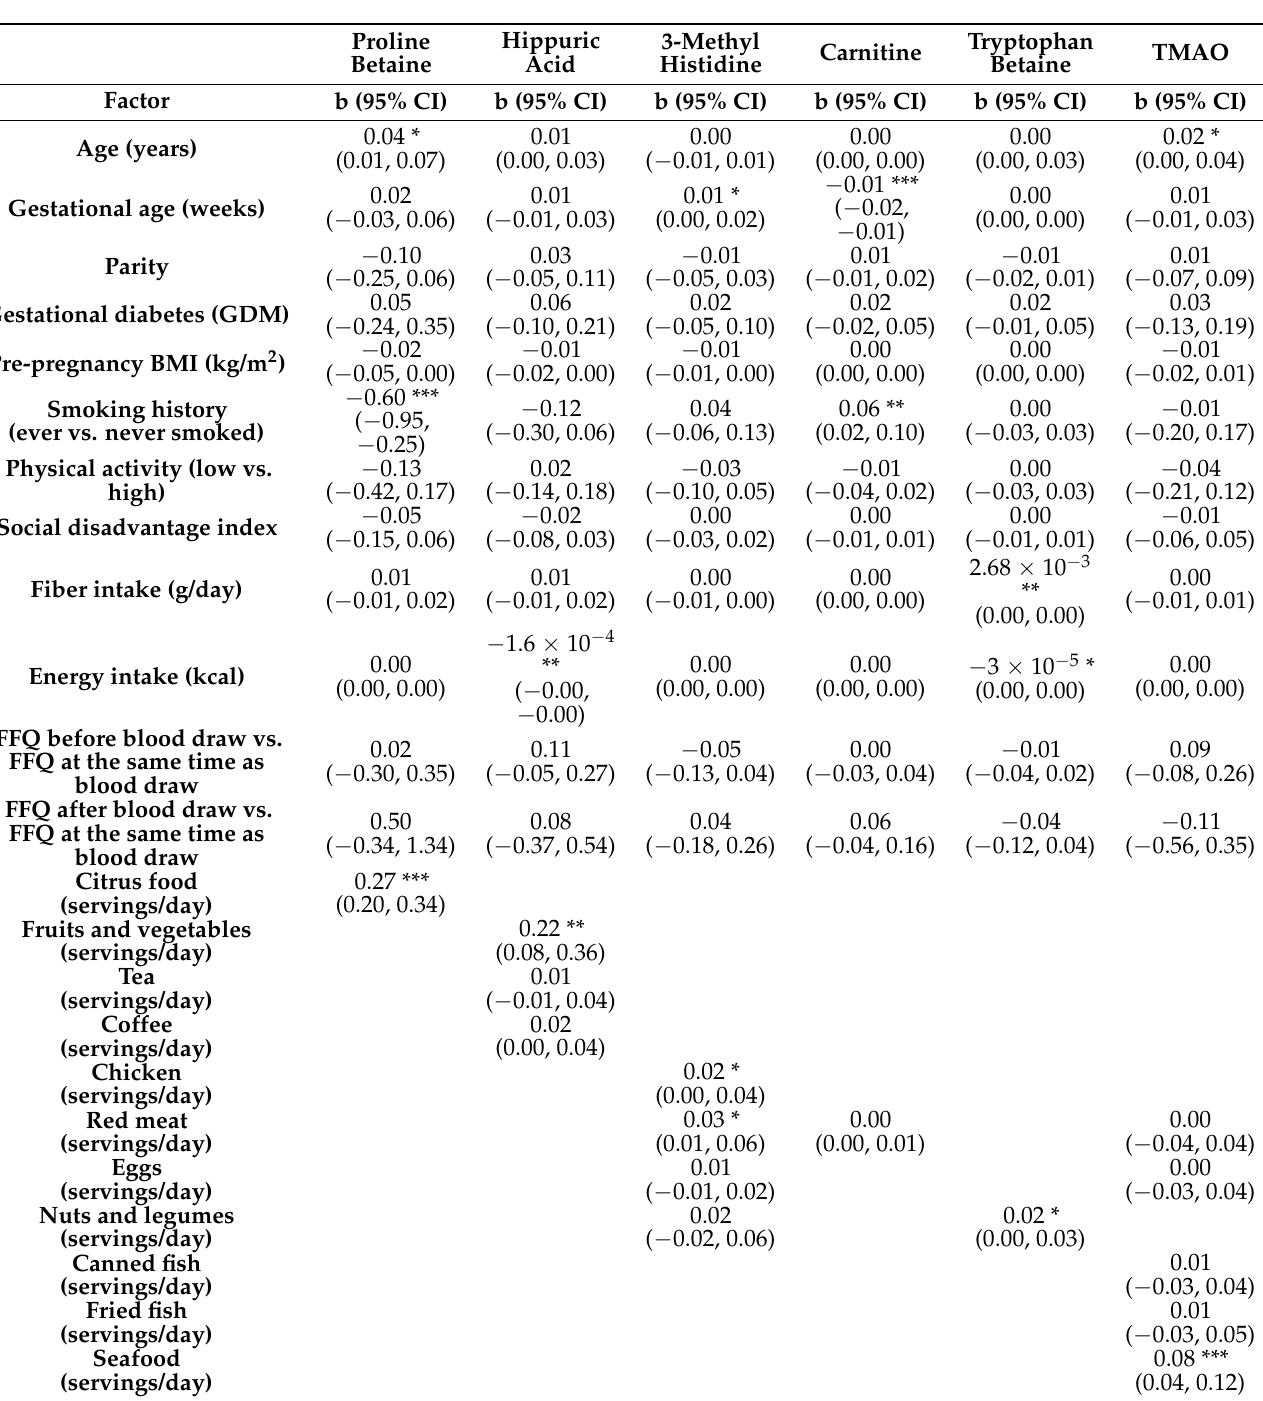
Table 2. Results from random effects hierarchical modelling examining the association of dietary and non-dietary factors with food-based metabolites.